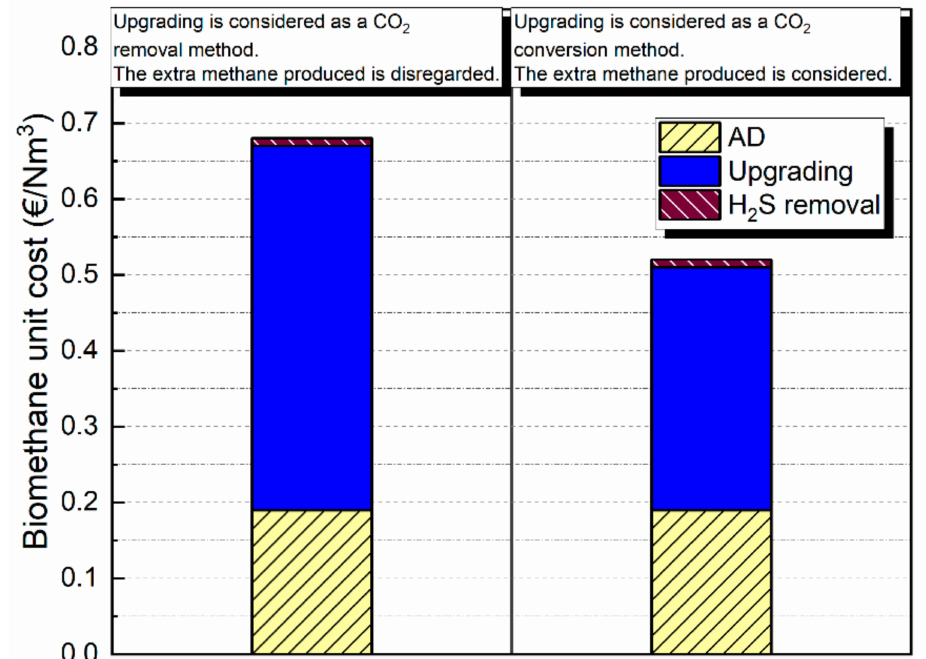
Figure 2. Comparison of biomethane unit costs considering upgrading as a CO 2 removal and conversion method, respectively.